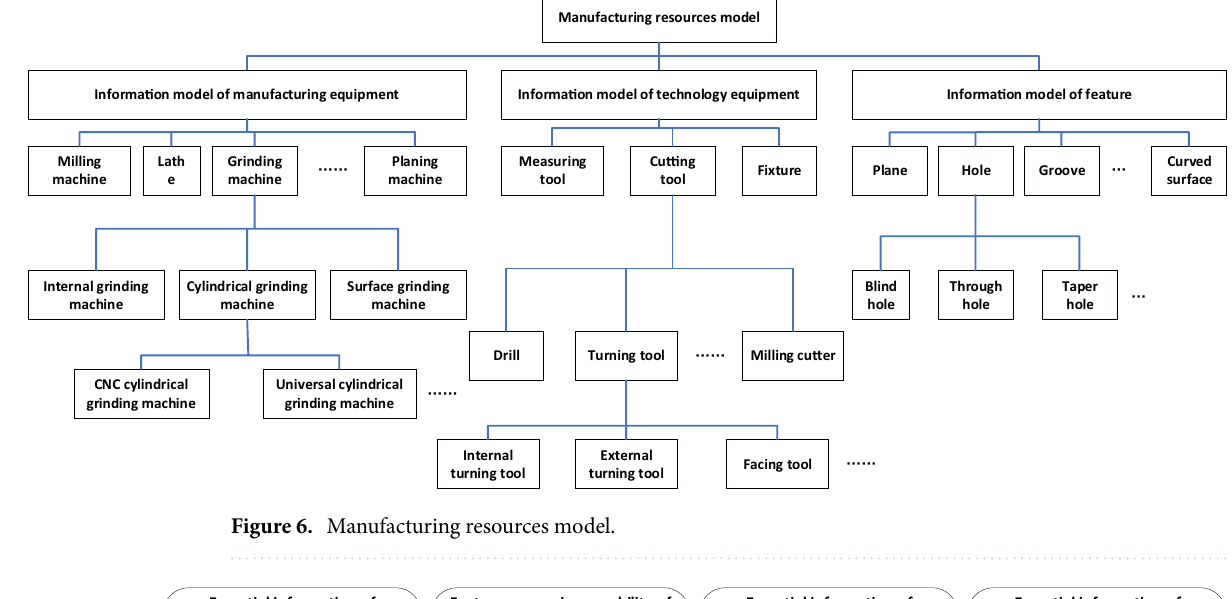
Figure 6. Manufacturing resources model.